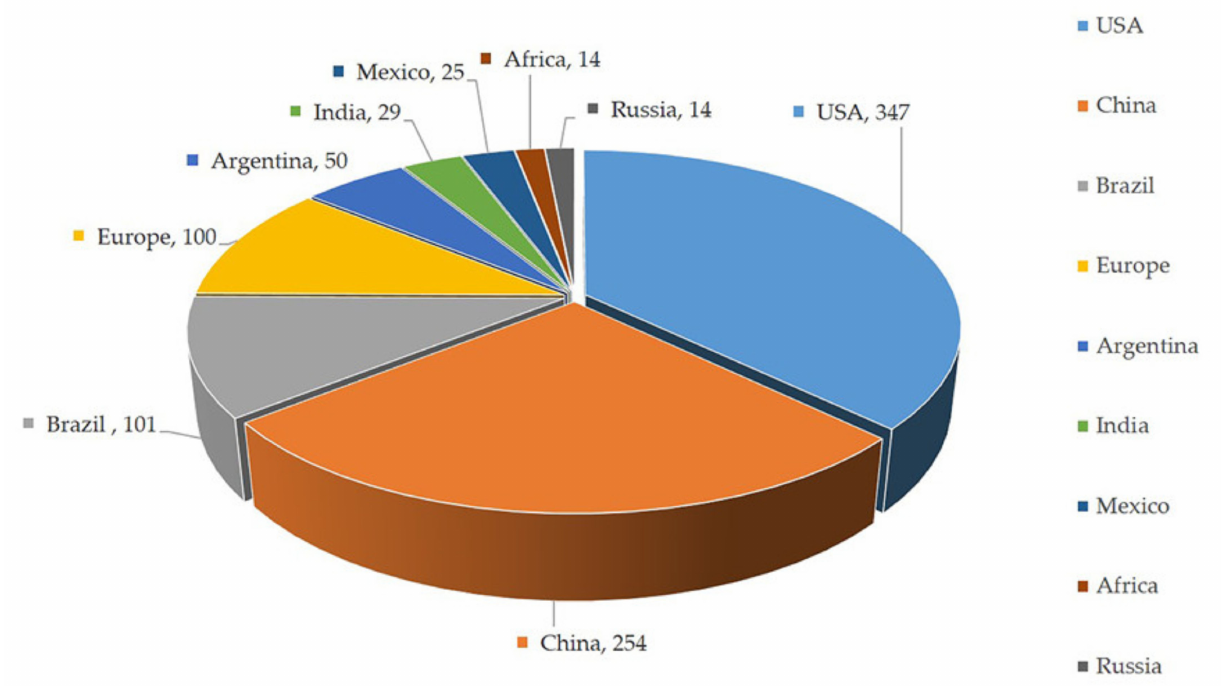
Figure 1. Top ten maize-producing countries of the world. The number followed by country name indicates area in millions of hectares [Source: Food and Agriculture Organization, 2020]